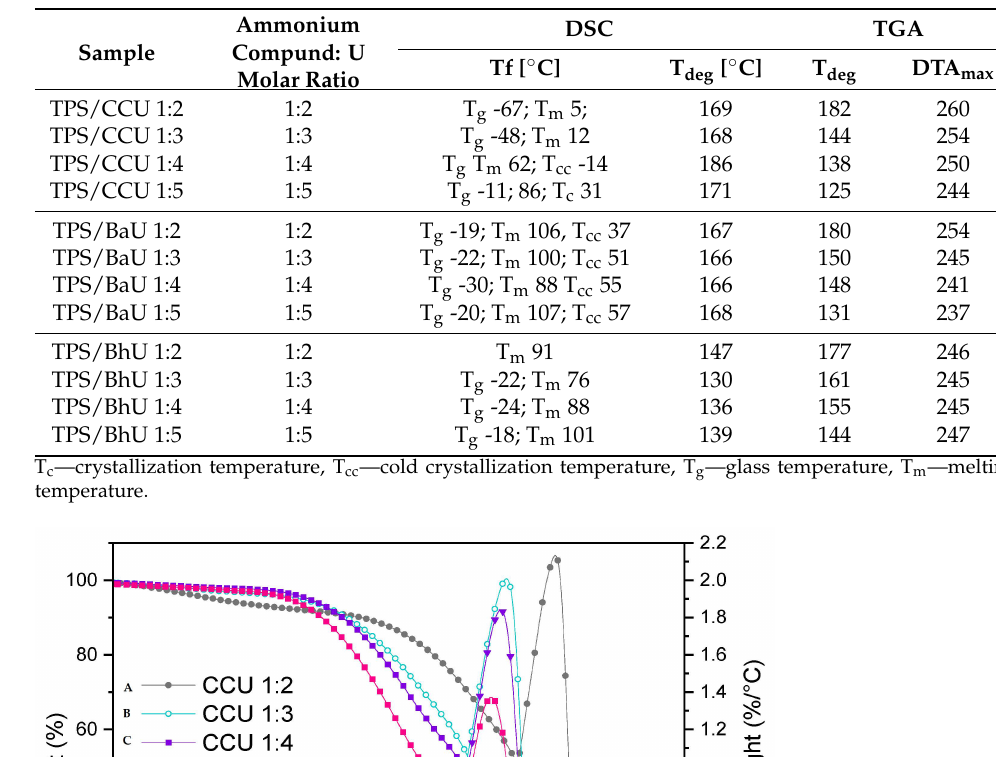
Table 1. Thermal properties of DESs with different urea content.